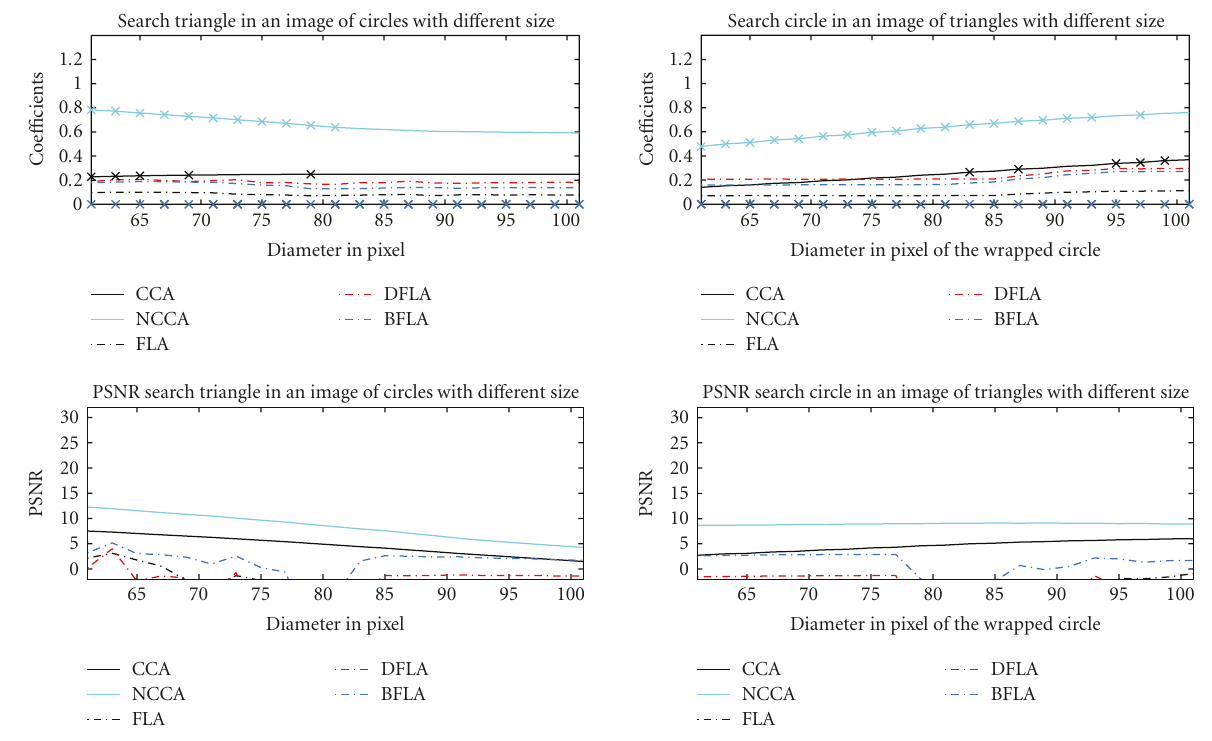
Figure 9: Influence of absent object on the coe ffi cients and the PSNR of the cross-correlation algorithms. The size is specified as the diameter of the object wrapped circle in pixels. Top: coe ffi cients of the cross-correlation algorithms, (marker—correct position found); bottom: PSNR of the cross-correlation algorithms; left: results of the circles; right: results of the triangles.